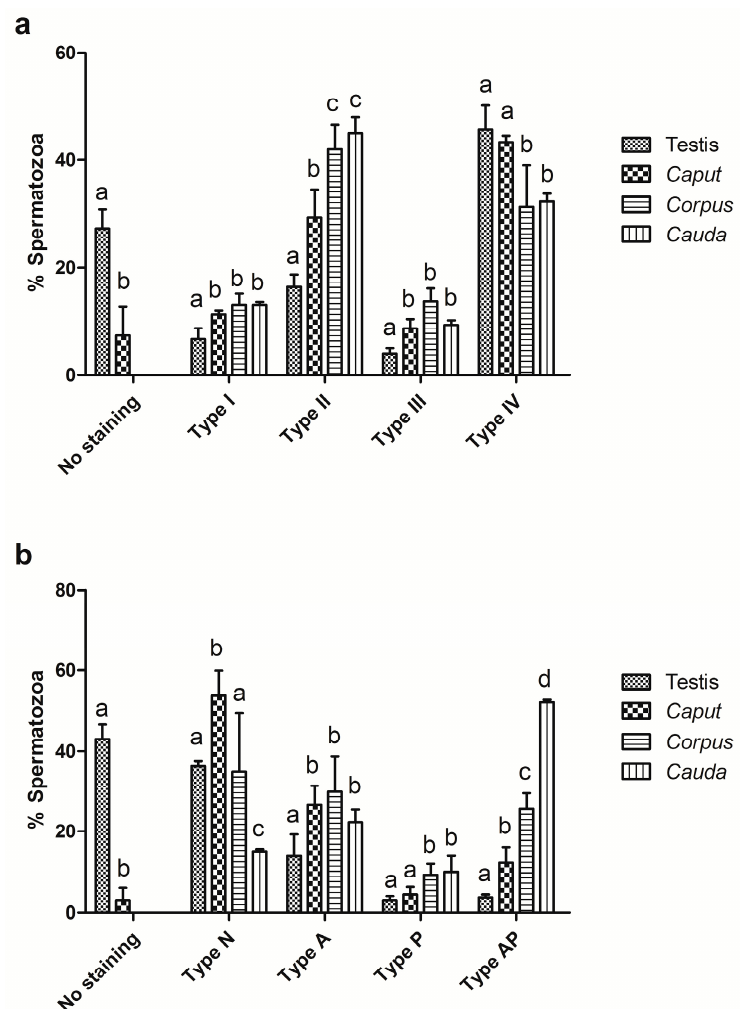
Figure 4. Percentages of the different immunotypes, assessed by indirect immunofluorescence (IIF) against MT 1 ( a ) and MT 2 ( b ) melatonin receptors in spermatozoa obtained from the testis and the caput, corpus, and cauda epididymis. For the MT 1 receptor, type I (labelling all over the head and tail), type II (equatorial and post-acrosomal regions, neck, and tail), type III (equatorial zone and tail), and type IV (staining only on the tail) were detected. For the MT 2 melatonin receptor, type A (more intense staining at the acrosome than the post-acrosome), type P (more intense staining at the post-acrosome region than the acrosome), type AP (the same intensity of immunostaining at both acrosome and post-acrosome), and type N (staining only in the neck) spermatozoa were identified. Additionally, spermatozoa without immunoreactivity were recorded for both receptors. Results are shown as mean ± SEM, n = 5. Different letters (a, b, c) mean statistical differences of p < 0.05.